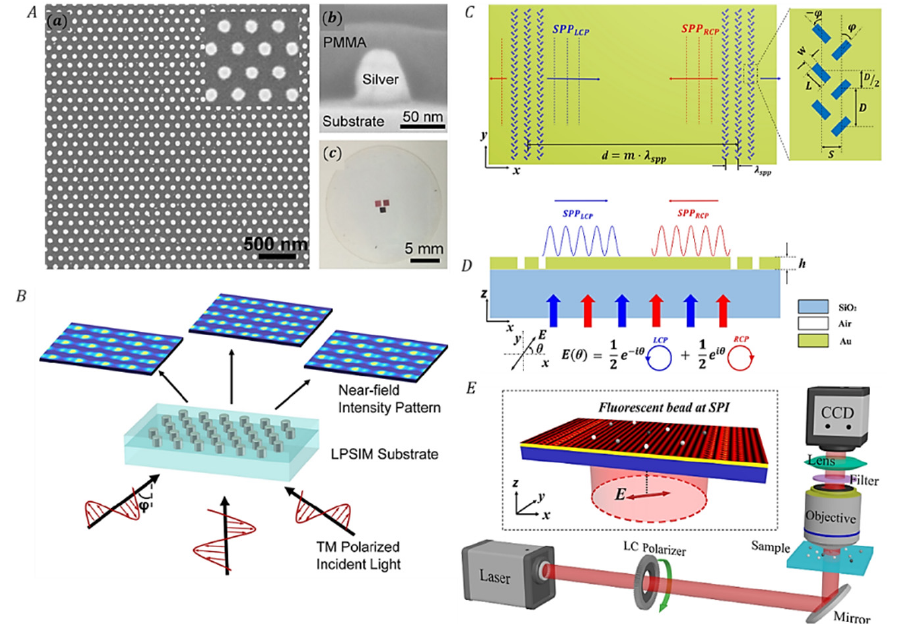
Figure 13. Development of correlative SIM and surface plasmon interference. ( A ). Schematic of LPSIM [125]. ( a ) Plasmonic antenna array at different magnifications with a hexagonal lattice shape. ( b ) Cross-sectional image of silver nanodisk. ( c ) LPSIM with three patterned antenna array areas with pitch sizes of 125, 135, and 145 nm. Copyright 2018 ACS Nano. ( B ). Near-field intensity pattern produced by the excitation beam on the object plane. ( C – E ). Principle and simulation of polarization-controlled tunable SPF-SIM [132]. ( C ). Schematic diagram of SPs on gold/dielectric surface excited by fishbone grating array. ( D ). Principle of SP for linearly polarized light excitation. ( E ). Schematics of the SPF-SIM system. The SPs shift laterally with modulation of the polarization angle using an LC polarizer. Copyright 2020 Nano Lett.